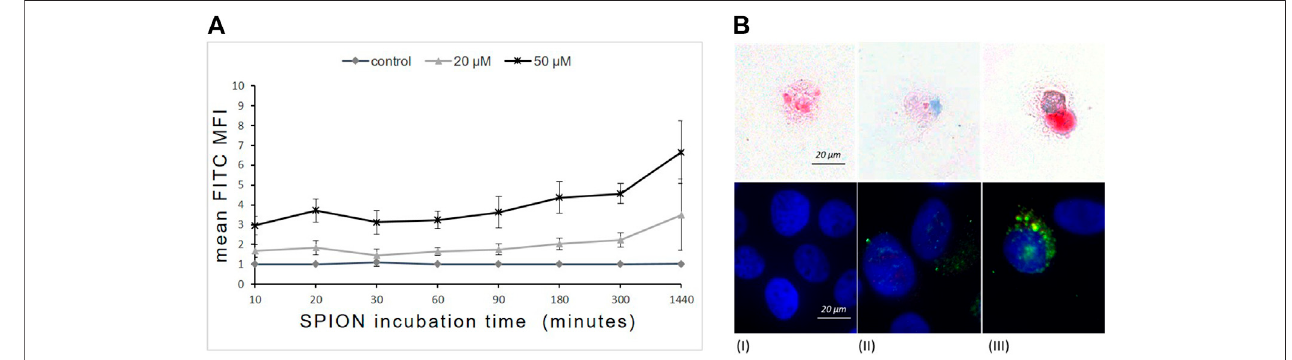
FIGURE 2 | Time- and concentration-dependent uptake of dextran-coated SPIONs by THP-1 monocytes. (A) FITC fl uorescence (mean fl uorescence intensity = MFI) of THP-1 cells measured by FACS that represents SPION uptake over time. n = 6. (B) Prussian`s blue staining of Fe (upper panel) and immuno fl uorescence (lower panel) of FITC-labeled SPIONs in THP-1 monocytes after 24 h of incubation. (I) control; (II) 20 µM Fe; (III) 50 µM Fe. Red arrows indicate iron accumulations in the cells. Blue fl uorescence shows DAPI stained nuclei and green indicates FITC-labeled